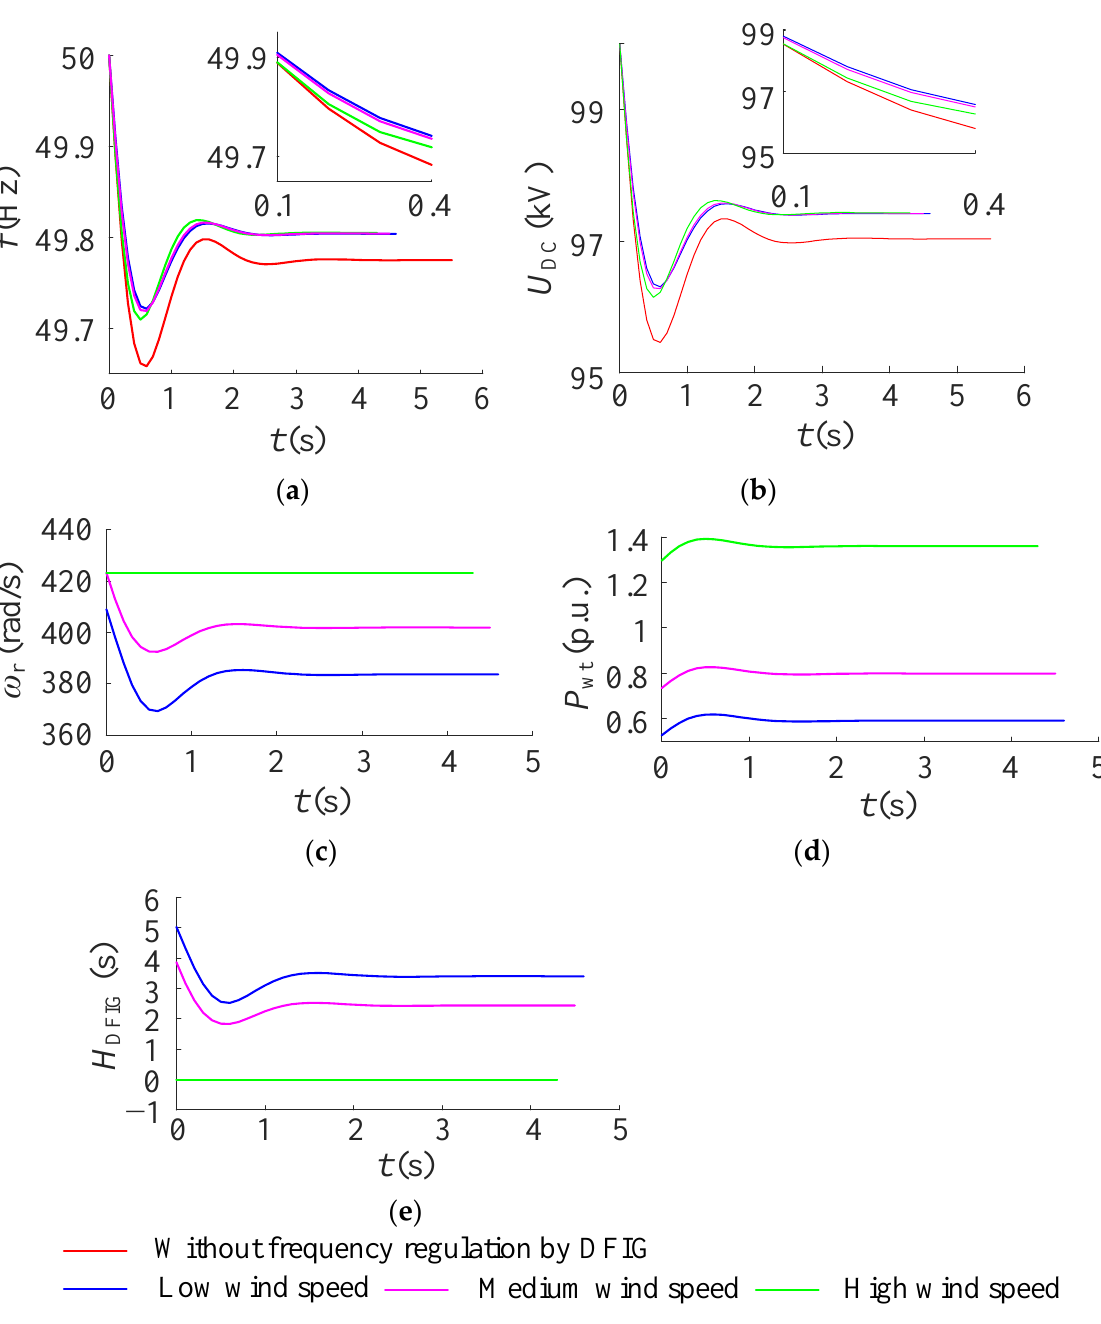
Figure 8. DPFs under different wind speeds: ( a ) System frequency; ( b ) DC voltage; ( c ) Rotor speed of DFIG; ( d ) Captured power of WT; ( e ) Inertia of DFIG.